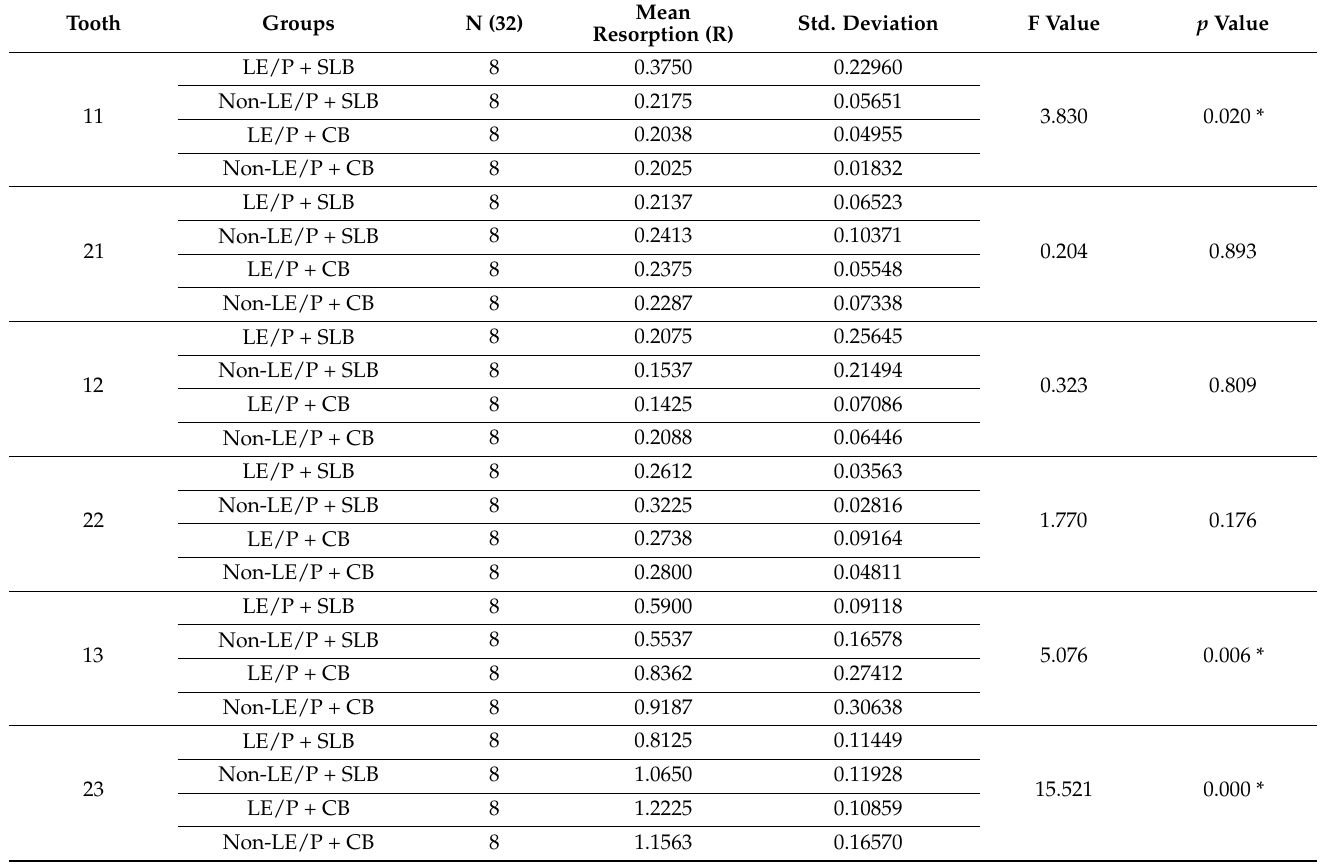
Table 3. ANOVA test results of mean root resorption (R) for the measured tooth (#11, #21, #12, #22,